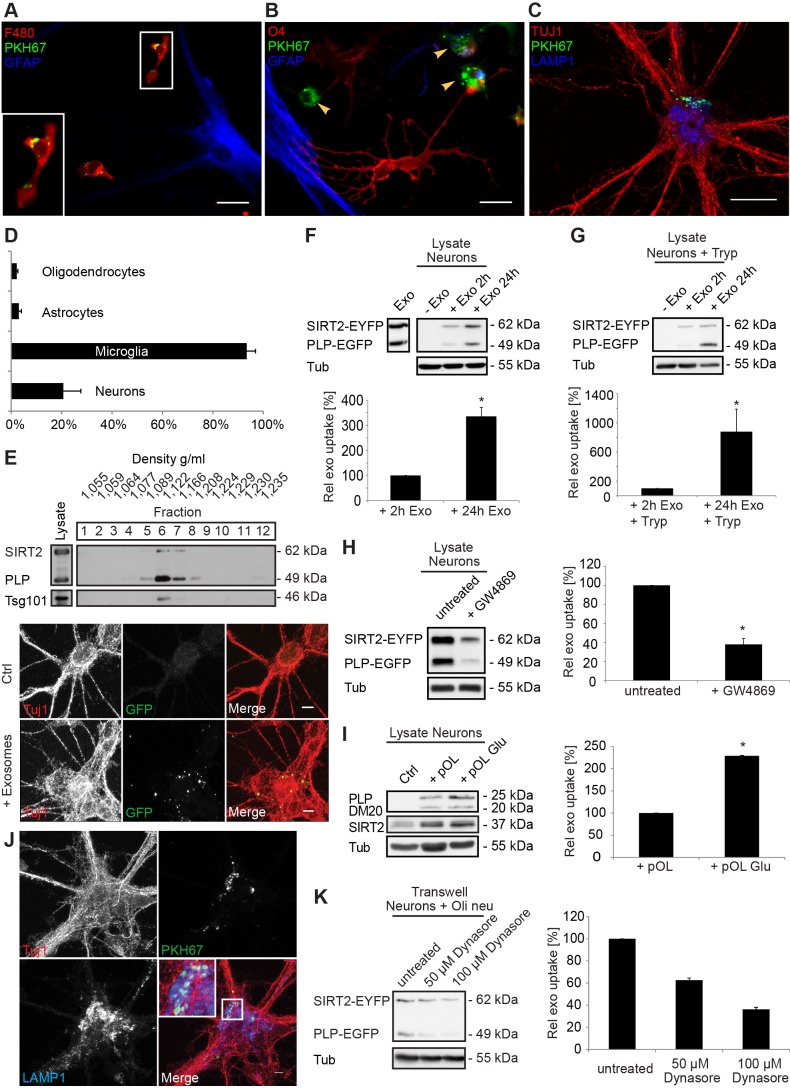
Primary cortical neurons internalize oligodendroglial exosomes.(A–D) pOL were stained with the lipophilic dye PKH67 (green), washed, and subsequently co-cultured in Boyden chambers for 2 d with mixed neural cultures containing astrocytes (A, B, blue marker GFAP), oligodendrocytes (B, red marker O4), and microglia (A, red marker F4/80, B, arrowheads) or with CN (C, red marker Tuj1). Scale bar, 20 µm. (D) Quantification of exosome uptake by the different types of target cells. Error bars, SEM, (n = 3). (E) Fluorescent exosomes containing SIRT2-EYFP and PLP-EGFP were purified by sucrose density gradient centrifugation from Oli-neu cells and co-incubated with CN for 24 h. The Western blot depicts EGFP and the exosomal marker Tsg101 in gradient fractions. Images show maximum projections of confocal Z-stacks of Tuj1-stained neurons after incubation with exosomes (scale bar, 5 µm). (F) Western blots of purified Oli-neu exosomes (input, left lane) and neuronal lysates after treatment with exosomes (Exo). EGFP/EYFP depicts exosome markers, Tubulin (Tub) is used as normalization standard. Relative exosome uptake reflects normalized signals of SIRT2-EYFP and PLP-EGFP associated with neuronal lysates (n = 8). (G) To remove surface-bound exosomes, neurons were treated with trypsin (Tryp) before lysis (n = 5). (H–K) Boyden chamber co-culture of oligodendroglial cells and CN for 2–3 d and analysis of exosomal PLP and SIRT2 in neurons by Western blot (H, I, and K) or immunostaining (J). (H) PLP-EGFP and SIRT2-EYFP expressing Oli-neu cells were treated or not with 5 µM GW4869 inhibiting exosome release (n = 6). (I) pOL were treated with 100 µM glutamate stimulating exosome release (n = 5). (J) Co-culture of CN with PKH67-labelled (green) pOL and immunostaining of CN with Tuj1 (red) and the late endosomal/lysosomal marker LAMP1 (blue). Maximum projection of a confocal Z-stack. Scale bar, 5 µm. (K) Neurons were pre-treated with Dynasore and co-cultured for 1 d with Oli-neu cells releasing SIRT2-EYFP and PLP-EGFP labeled exosomes (n = 4). Error bars, SEM (* p<0.05; Wilcoxon-test).